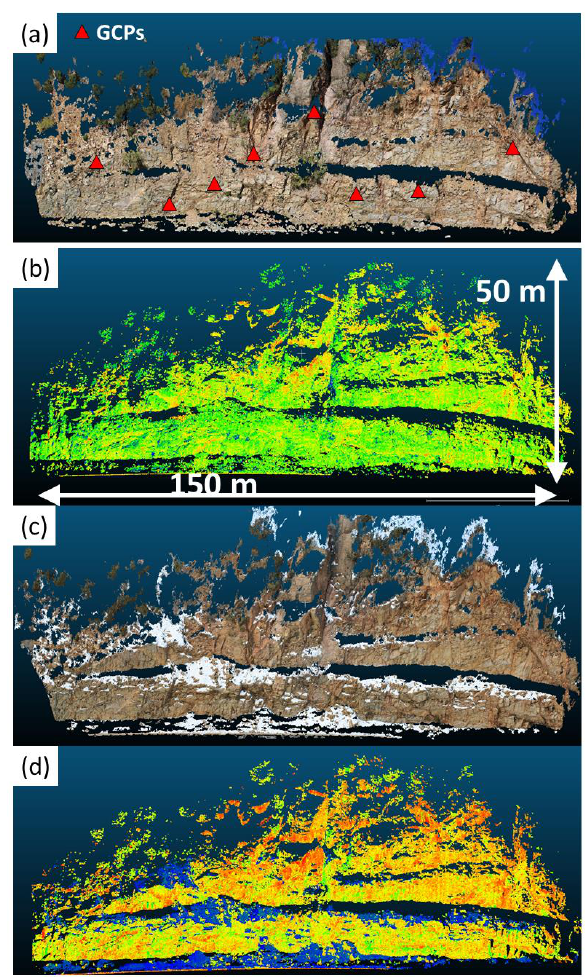
Figure 4. Study area and datasets for the Glenwood Canyon, Colorado site. (a) TP October 13 of 2018; terrestrial laser scanning October 13 of 2018; (c) TP January 19 of 2019; (d) terrestrial laser scanning January 19 of 2019.